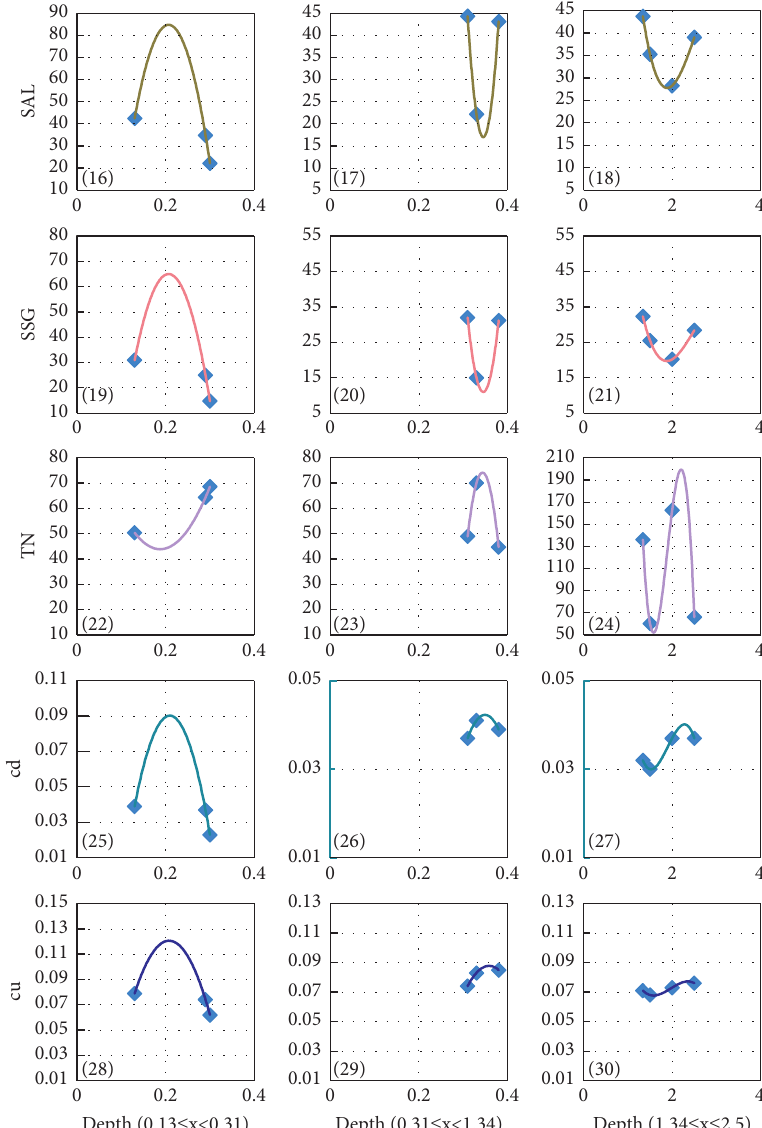
Figure 9: Estimation of the regressions of SAL, SSG, TN, cd, and cu in Lake Manzala,